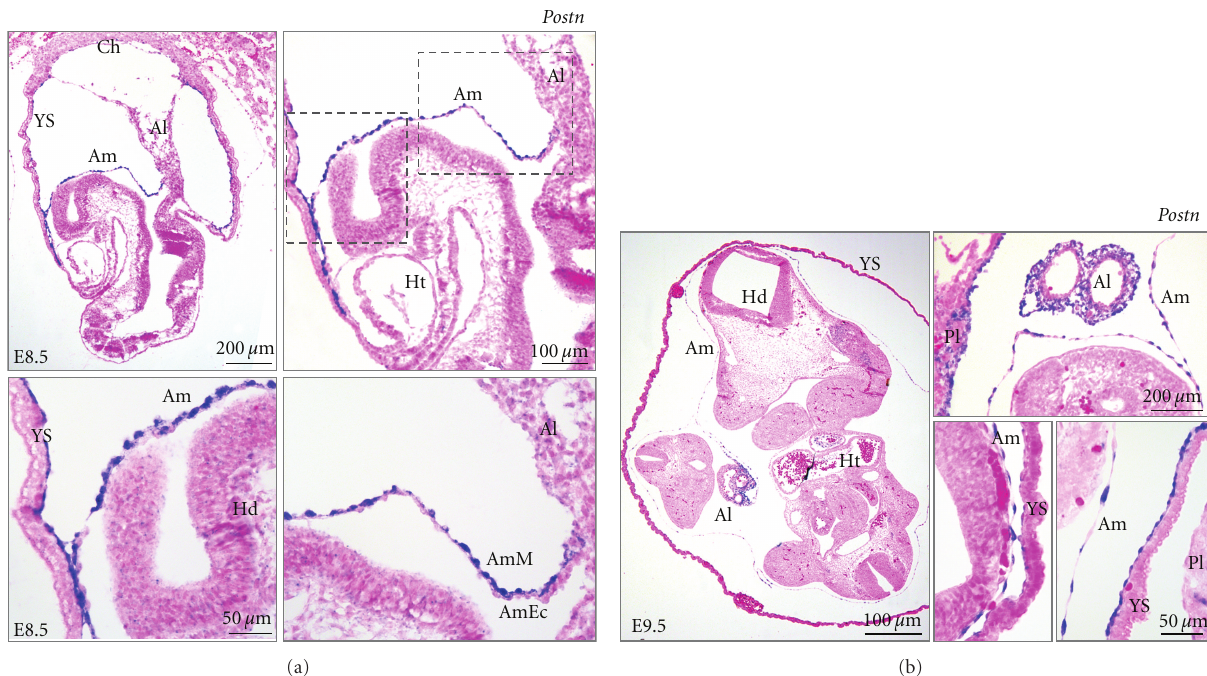
Figure 3: In situ hybridization on sections of mouse embryos. (a) RNA localization (blue) of Postn in E8.5 mouse embryos. Boxed areas are shown at a higher magnification. Postn appears localized in the amniotic mesoderm. (b) RNA localization (blue) of Postn in E9.5 mouse embryos. Abbreviations: Am: amnion; Al: allantois; AmM: amniotic mesoderm; AmEC: amniotic ectoderm; Ch: chorionic plate; Ht: heart;